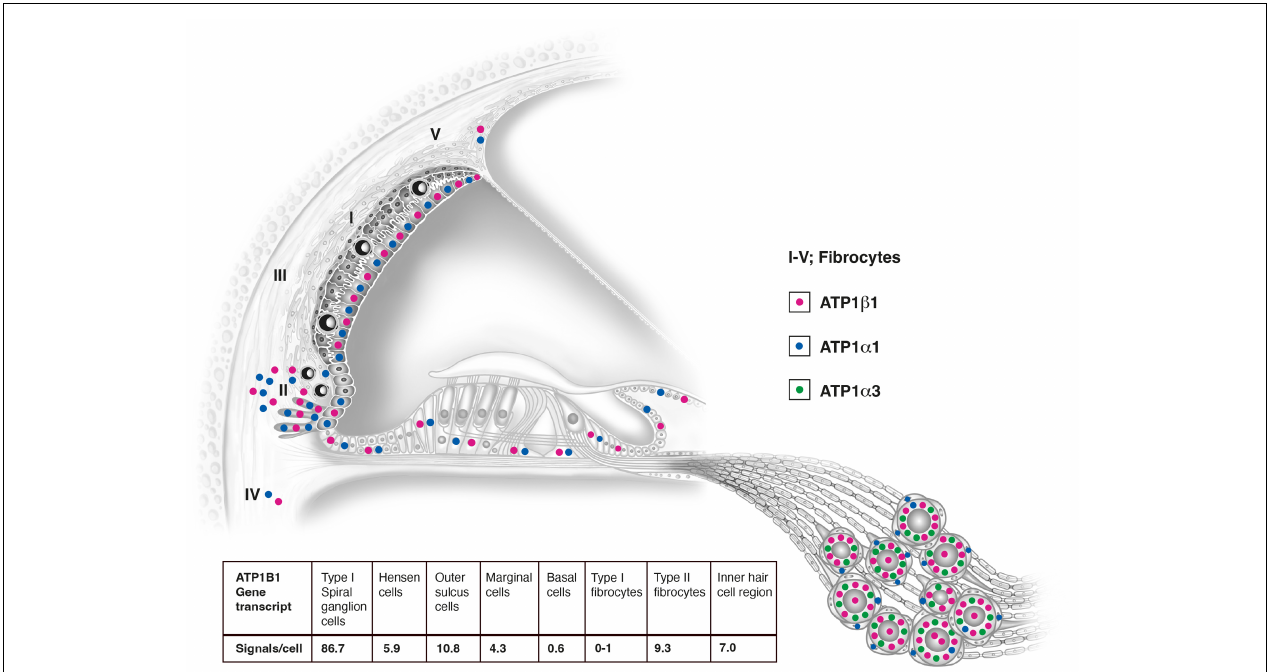
FIGURE 11 | Relative distribution of ATP1A1 , ATP1A3 , and ATP1B1 gene transcripts in the human cochlea based on RNAscope R (cid:13) ISH. Gene transcription may suggest that the lateral pathway of K + cycling from the organ of Corti is dominant. Type I spiral ganglion cells contain the largest number of mRNA gene puncta. They overcame signal counts in marginal cells 20 times and type II fibrocytes nine times. The number of counts in the ganglion cells was probably higher since many puncta were concentrated in clusters due to their large number near the plasmalemma. Results of quantitative analysis of ATP1B1 signal counts per cell in different cellular domains of the human cochlea are shown and in Table 2